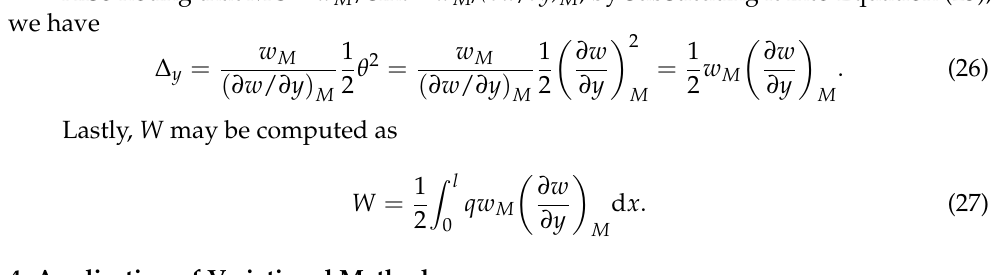
the y axis at point C , and θ is the angle between lines AC and MC . Note that θ is a small quantity, and thus, we have the relations AC = MC , θ = ( ə w/ ə y ) M and MB = w M , in which